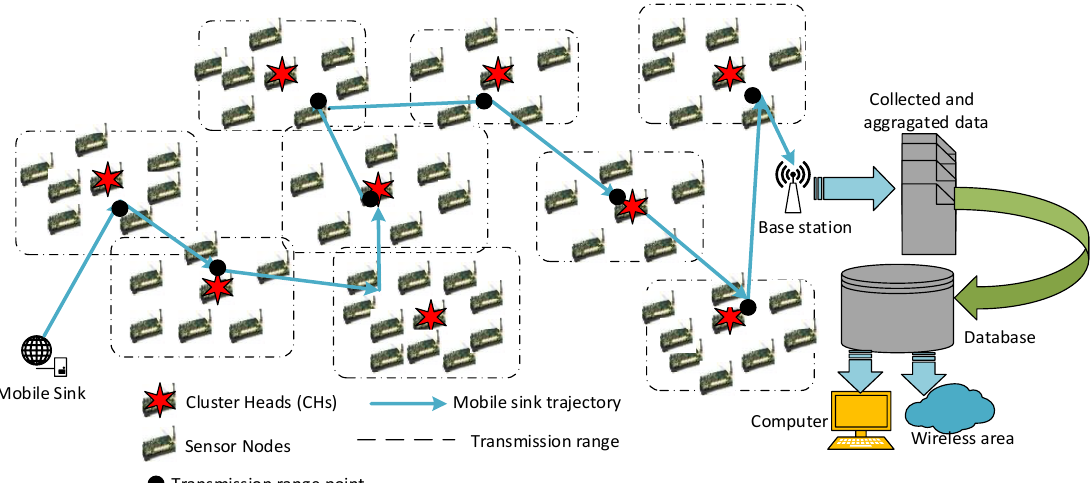
Figure 7. A sample of Mobile Sink (MS) trajectory.